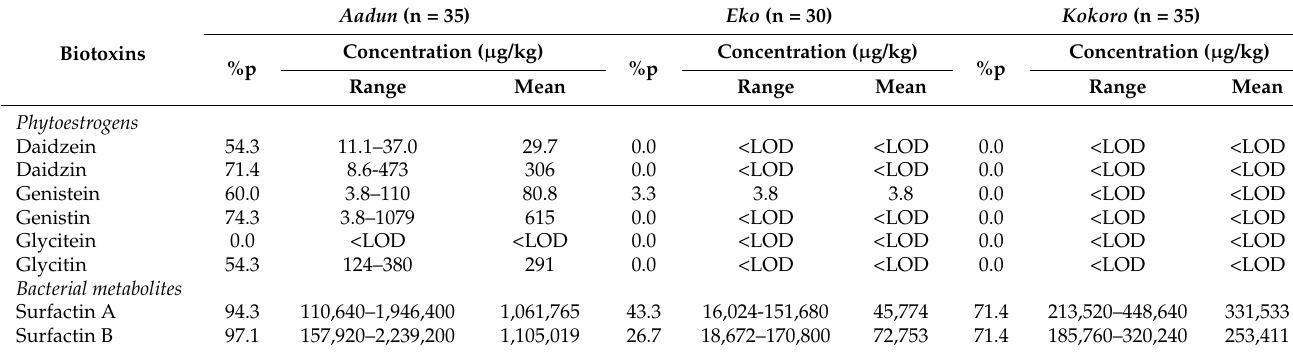
Table 4. Regulated mycotoxins, phytoestrogens, phytotoxins, and bacterial metabolites in